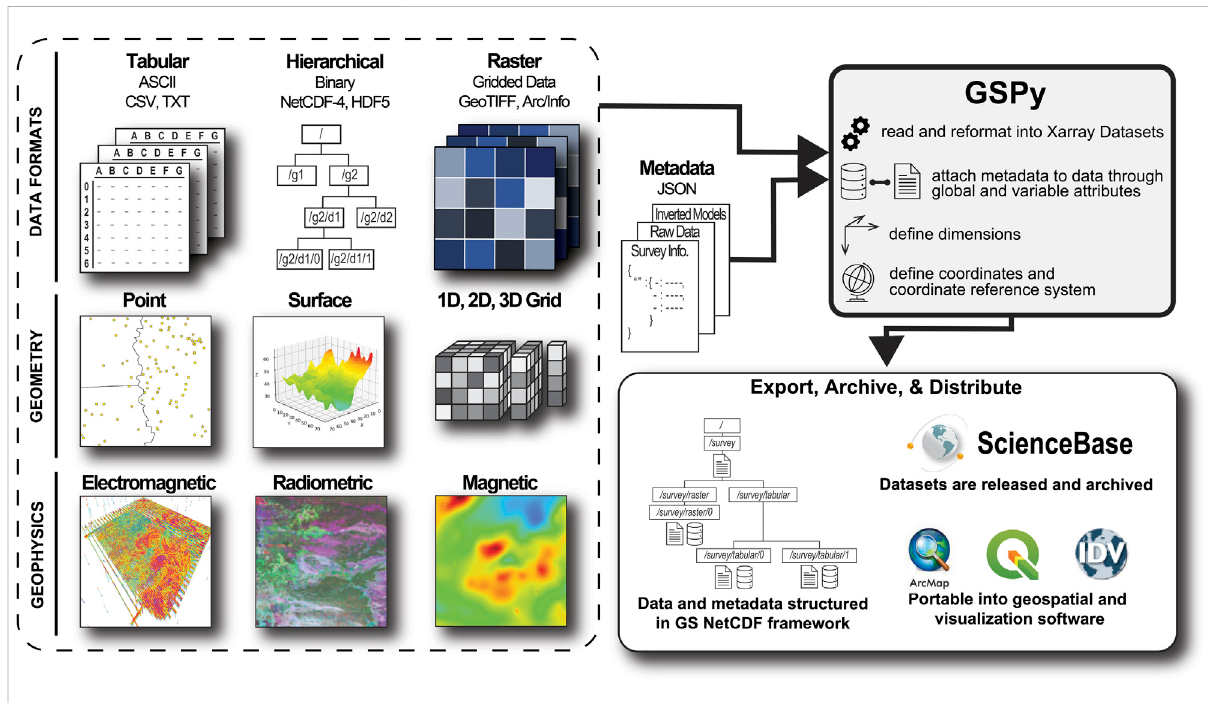
FIGURE 1 ConceptualdiagramofGSPywork fl ow.DatafromavarietyofformatsandtypesarereadintoGSPy,alongwithrequiredmetadata fi les.Through the GSPy software, data are converted into a standardized NetCDF fi le containing the dataset and metadata appropriate for archiving and